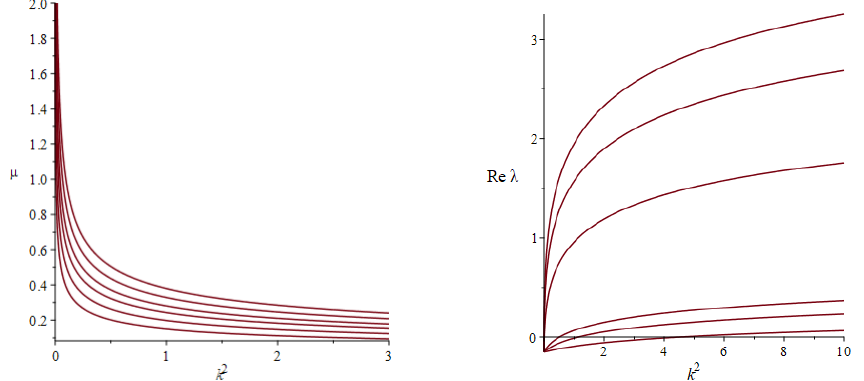
Figure 2. The typical neutral curves of µ versus squared wavenumber for five values of α = 0.5,0.87,1.12,1.43,1.8,2.0 ( left panel) and graphs of the increments of the eigenmodes (Re λ ) vs. the squared wavenumbers for µ = 0.1,0.18,0.25,1.25,2.25,3.0 and α = 3/4 ( right ). Each increase in the diffusivity coefficient increases the increment so that its graph moves upward and crosses the horizontal axis closer to zero. On the left panel, the area of stability is confined within the coordinate axes and the neutral curves. Each increase in α widens the stability areas so that the neutral curves moves right and upward. The values of other parameters are as follows: ν = 1, γ = 2/3, β = 0.4 γα , χ = χ cr , and θ is equal to its